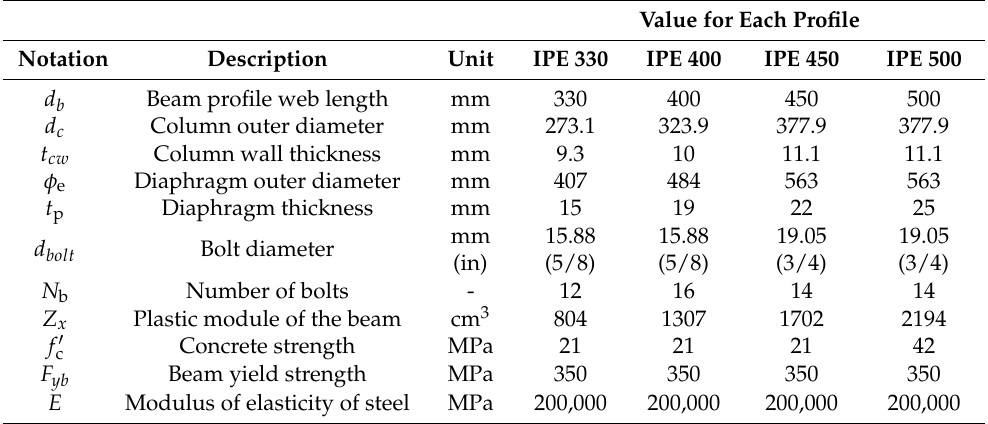
Figure 1. Components and main dimensions of the connection obtained from the design process. The action of the maximum capacity force F pr and the maximum probable moment M f are also illustrated [19]. Table 1. Relevant parameters required for the design of the beam-column connections analyzed in the parametric study.